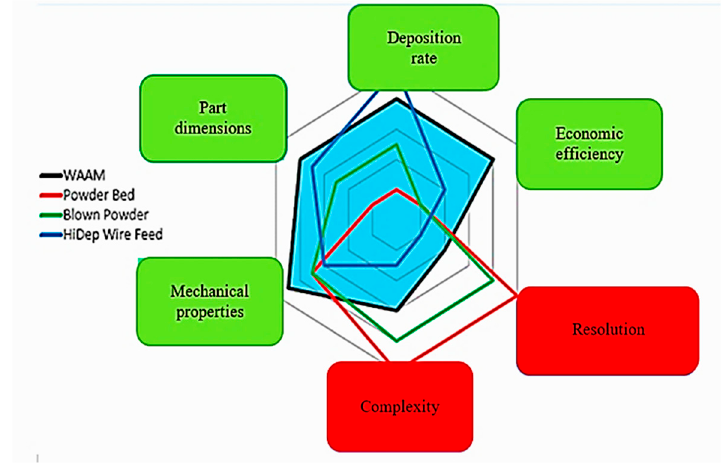
Figure 1. Comparison of advantages and disadvantages between different methods of AM [5].